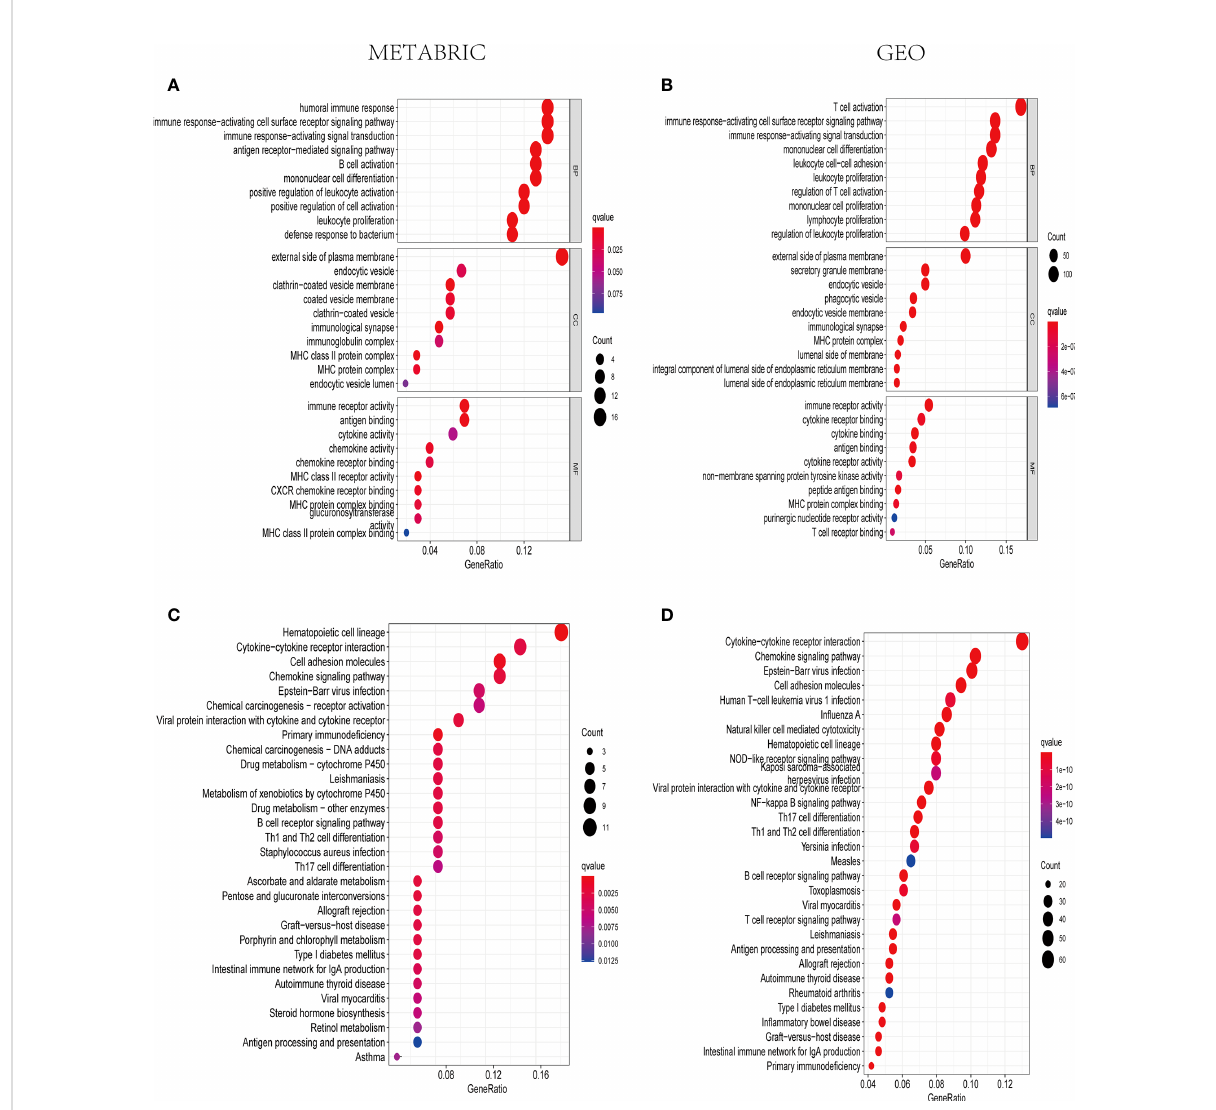
FIGURE 6 The representative outcomes of GO and KEGG enrichment analysis. The top 10 GO terms of BP, CC, and MF enrichment in DEGs between the high- and low-risk sets in the METABRIC (A) and GEO groups (B) . The 30 enriched KEGG pathways in DEGs between the high- and low-risk sets in the METABRIC (C) and GEO groups (D)